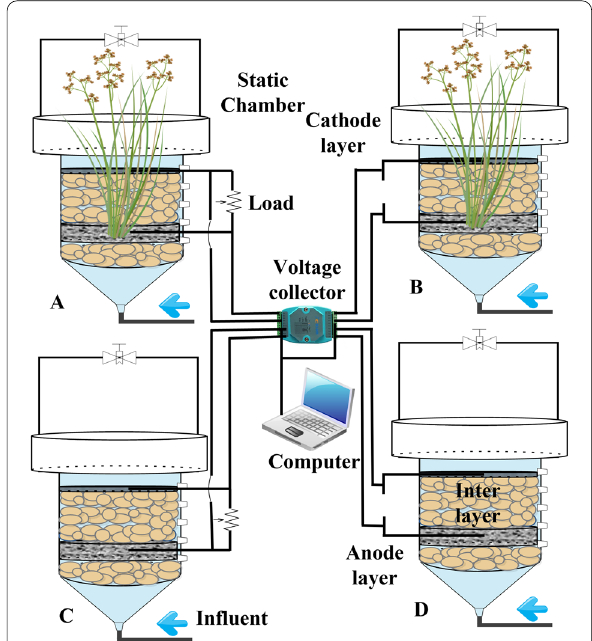
Fig. 1 Configuration of the CW–MFC. Closed‑circuit/with plants group (group A CCP), open‑circuit/with plants group (group B OCP), closed‑circuit/without plants group (group C CCN), and open‑circuit/ without plants group (group D